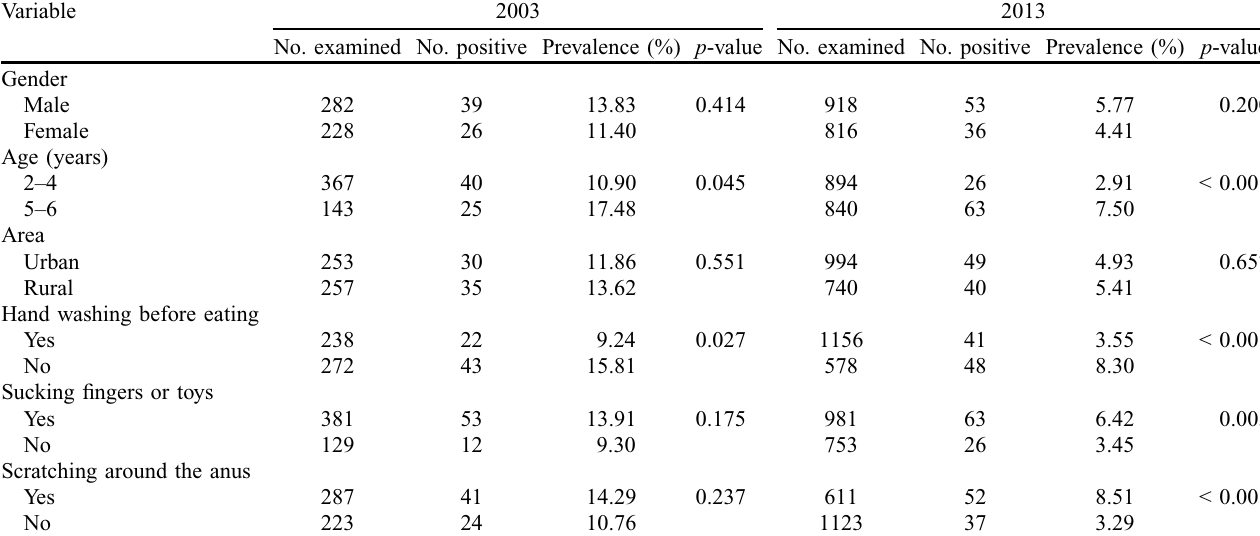
Table 2. Results of univariate analysis of risk factors and Enterobius vermicularis infection in the study participants.